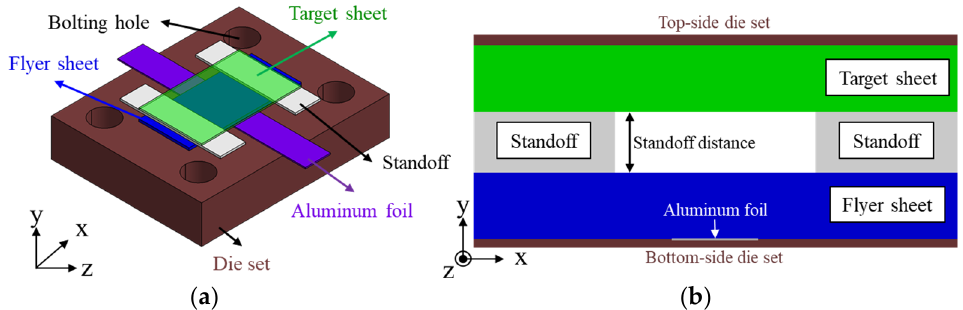
Figure 2. Initial set-up of the conventional VFAW experiment: ( a ) stacking sequence with specimen and vaporizing Al foil; ( b ) sectional view for stacked specimen.